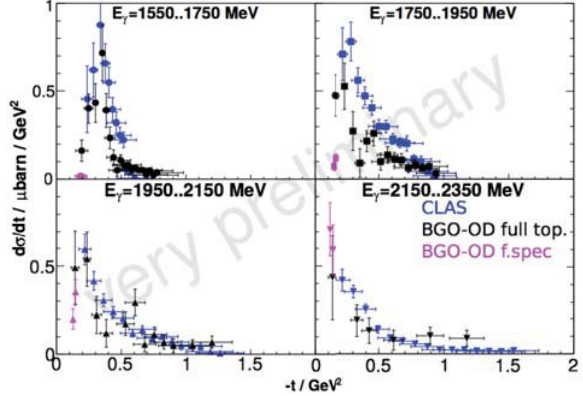
Figure 14. The same data shown in Fig. 13, but plotted vs − t (black and magenta points show the full topology and forward K + analysis respectively). Blue points are previous data of Moriya et al. [37]. Analysis by G. Scheluchin